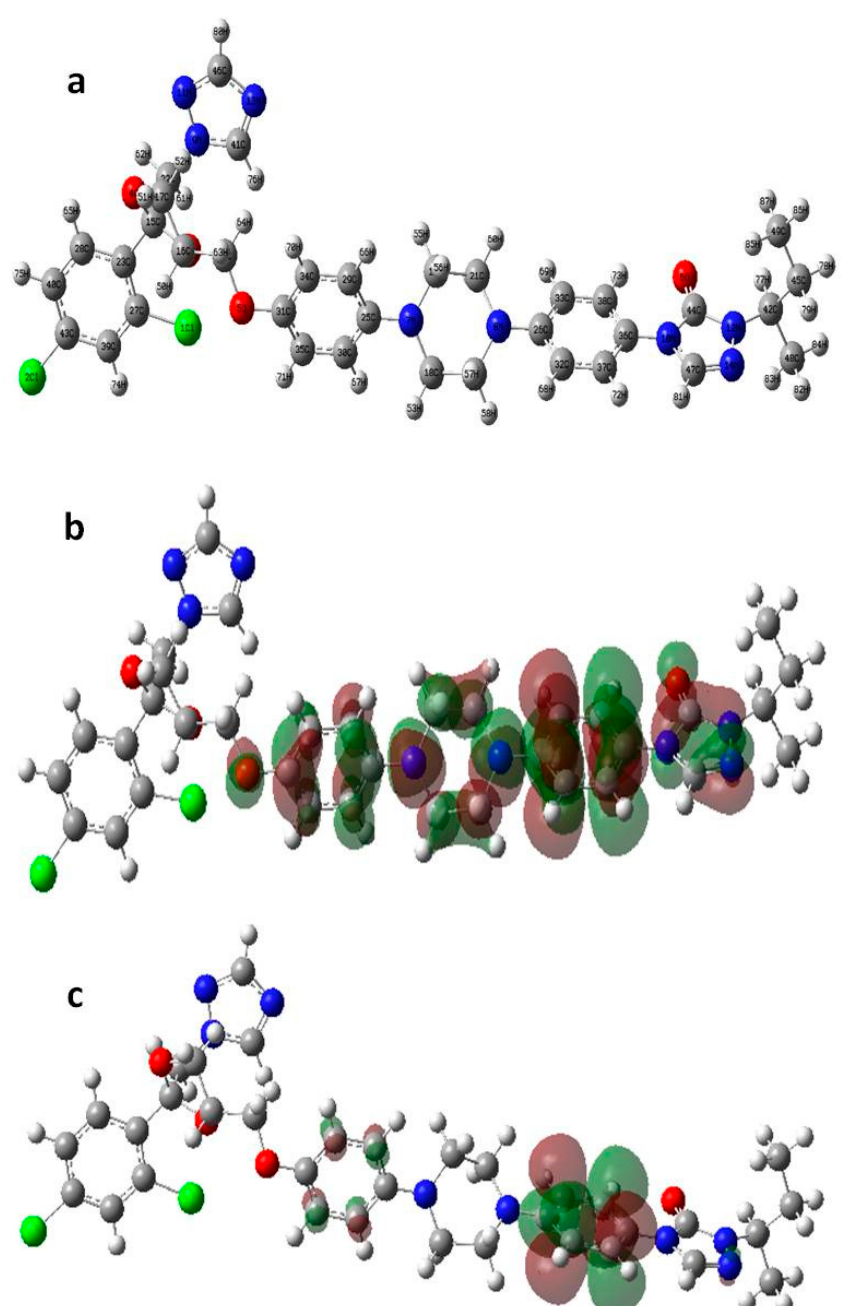
Figure 7. The highest occupied molecular orbital–lowest occupied molecular orbital (HOMO–LUMO) diagram of Itraconazole. ( a ) Optimized structure; ( b ) HOMO; ( c ) LUMO. The positive (red) and negative (green) phase distributions in the molecular orbital wave function. HOMO (electron donor regions) determines the ionization potentials. LUMO (electron acceptor regions) determines the electron